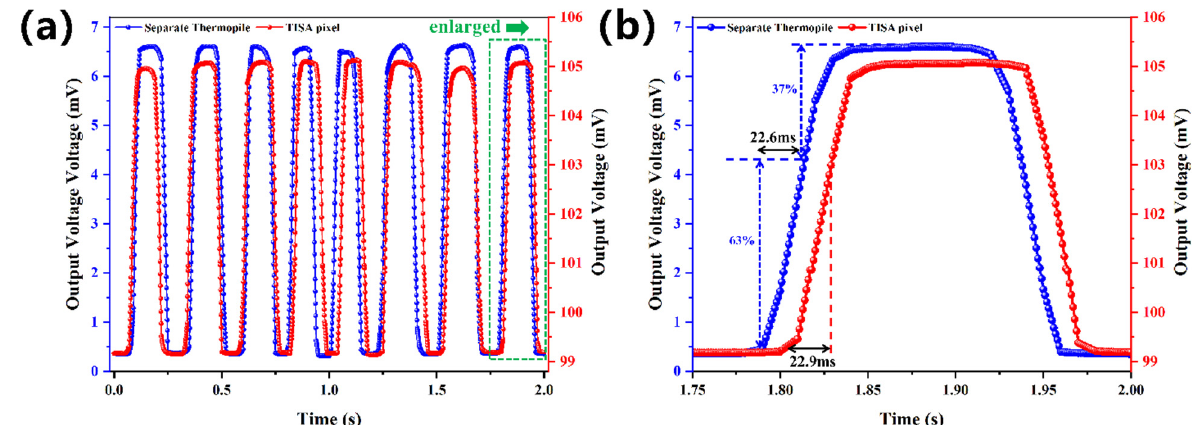
Figure 8. ( a ) Response voltages of the TISA pixel and the separate thermopile under a blackbody radiation of 100 °C and a chopper frequency of 4 Hz in 2 s, ( b ) One enlarged period of the response body radiation of 100 ◦ C and a chopper frequency of 4 Hz in 2 s, ( b ) One enlarged period of waveform. the response waveform.